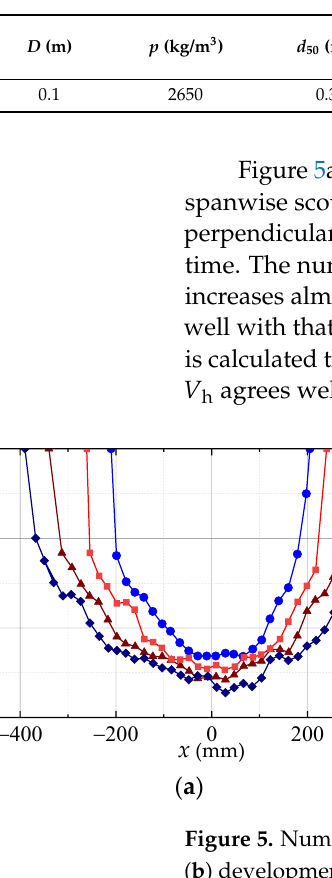
Table 3. 3D-single pipeline scour model parameters.